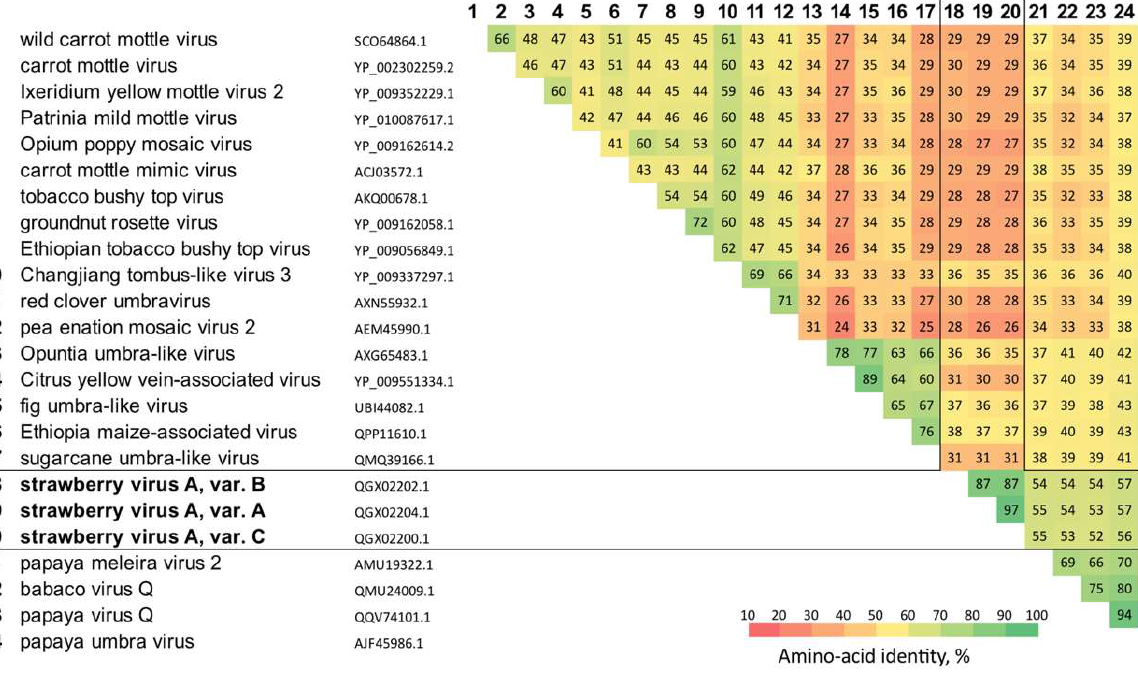
Figure 3. Conservation of amino acid identities in the polymerase gene of StrVA and related viruses.